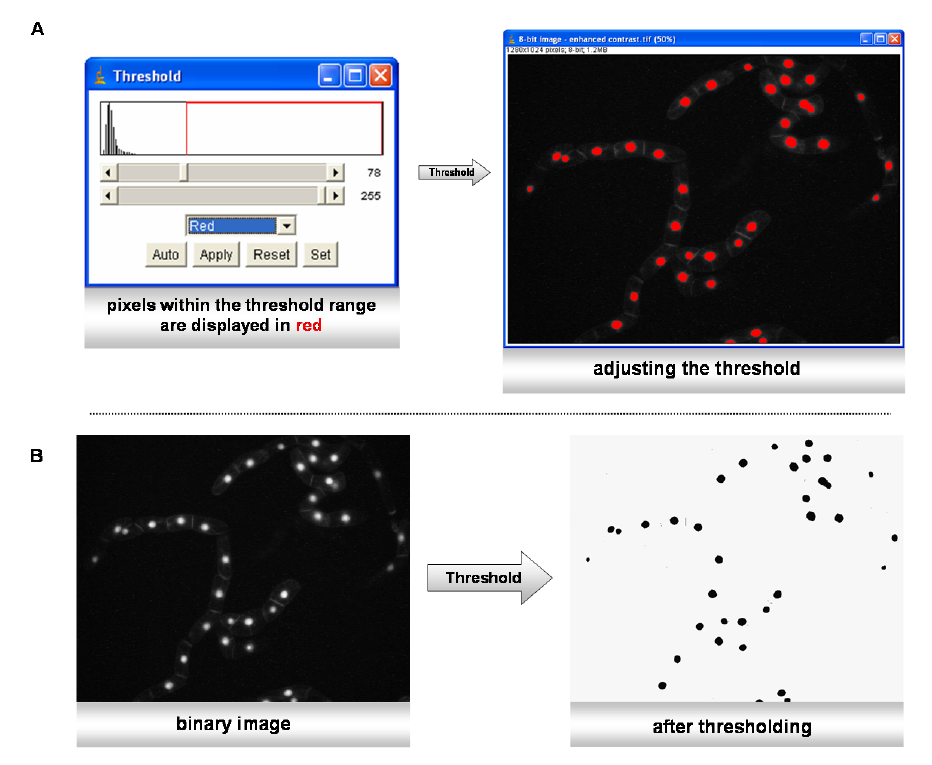
Figure 3. Threshold process. A ) The threshold range can be adjusted automatically. Red pixels show objects that are within the threshold range. B ) After pushing the “apply” button, the image is converted to black and white.